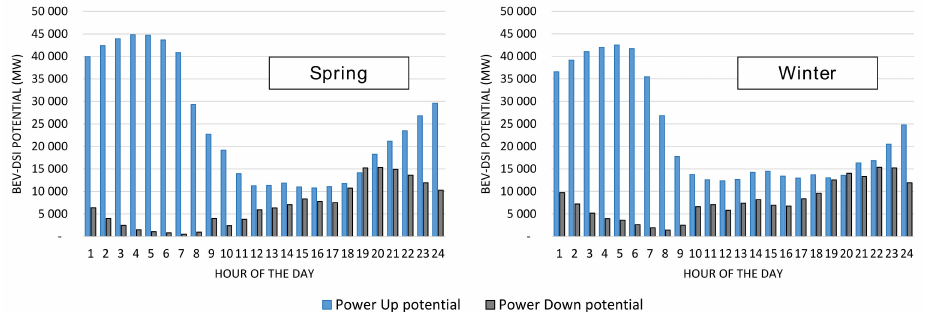
Figure 5. PowerUp (blue) and PowerDown (dark grey) flexibility potential of all BEVs for a typical Monday in spring and winter terms.